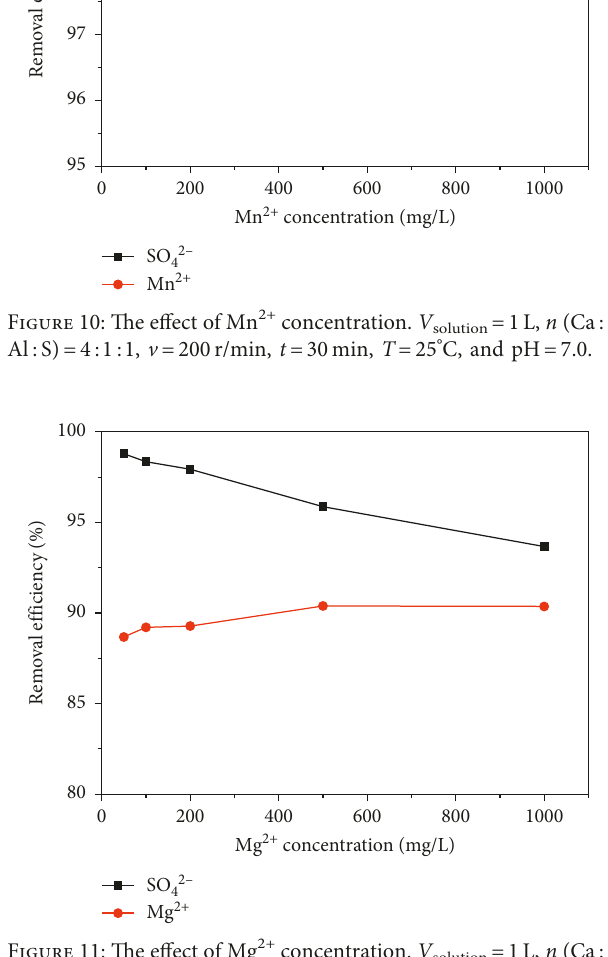
solution (cid:27) 1L, n (Ca : 25 ° C, and pH (cid:27)